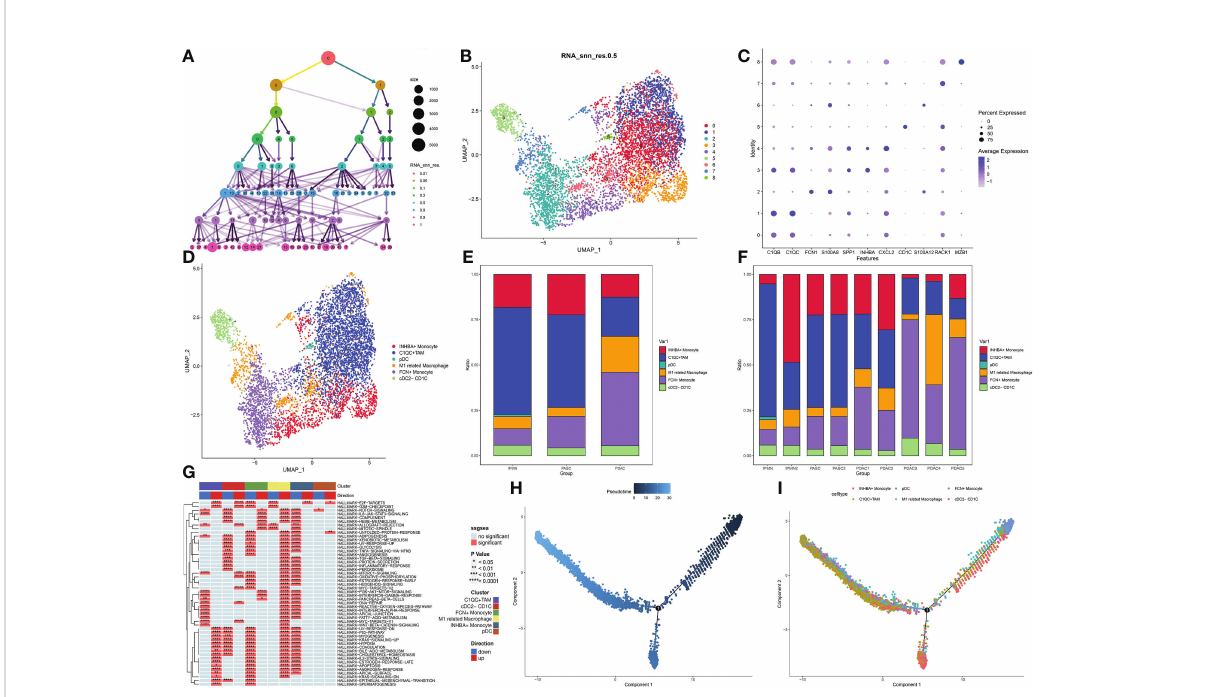
FIGURE 2 (A) Cluster tree of subgroup amounts at different resolution ratios. (B) UMAP cluster plot shows the divided subgroup before annotation. (C) Expression of each marker in each subgroup. (D) UMAP cluster plot shows the divided subgroup after annotation. (E) Bar graph of the proportion of each identi fi ed subgroup in each sample. (F) Bar graph of the proportion of each identi fi ed subgroup in each group. (G) GSVA plot showing the differentially enriched pathways in each identi fi ed subgroup. (H, I) Pseudotime analysis of these annotated groups. UMAP, Uniform Manifold Approximation and Projection; GSVA, gene set variation analysis.